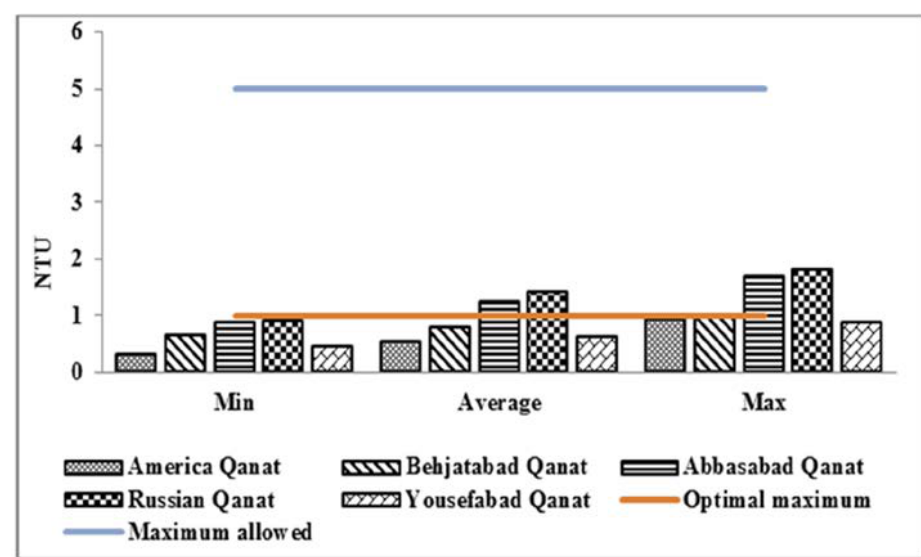
Fig. 9: Turbidity level and its comparison with the WHO and the National Standard of Iran